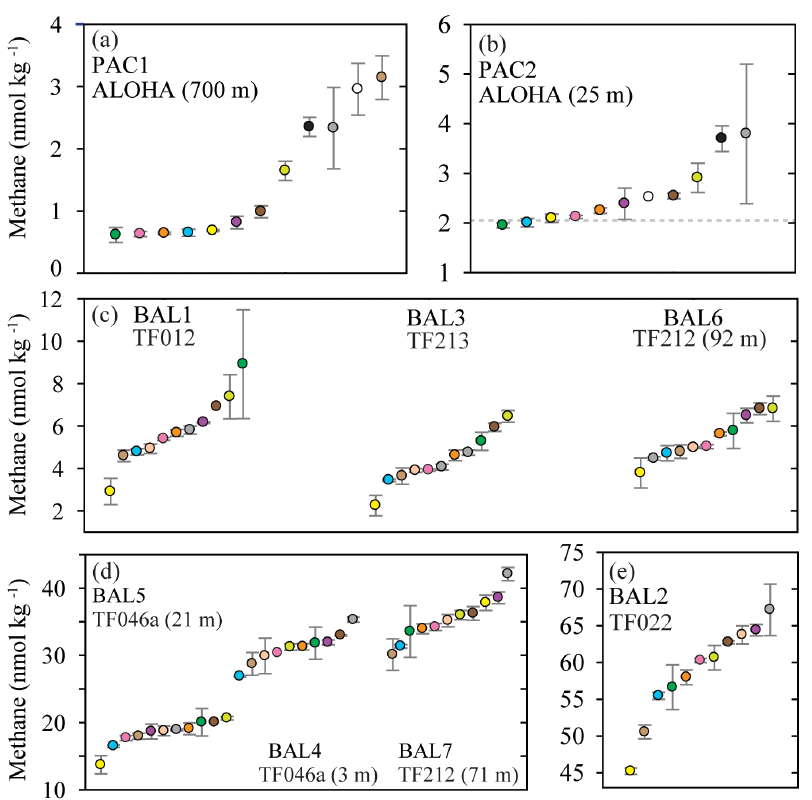
Figure 1. Concentrations of methane measured in nine separate seawater samples collected from the Pacific Ocean (a, b) and the Baltic Sea (c, d, e) . The dashed grey line represents the value of methane at atmospheric equilibrium (b) . Individual data points are plotted sequentially by increasing value. The same color symbol is used for each laboratory in all